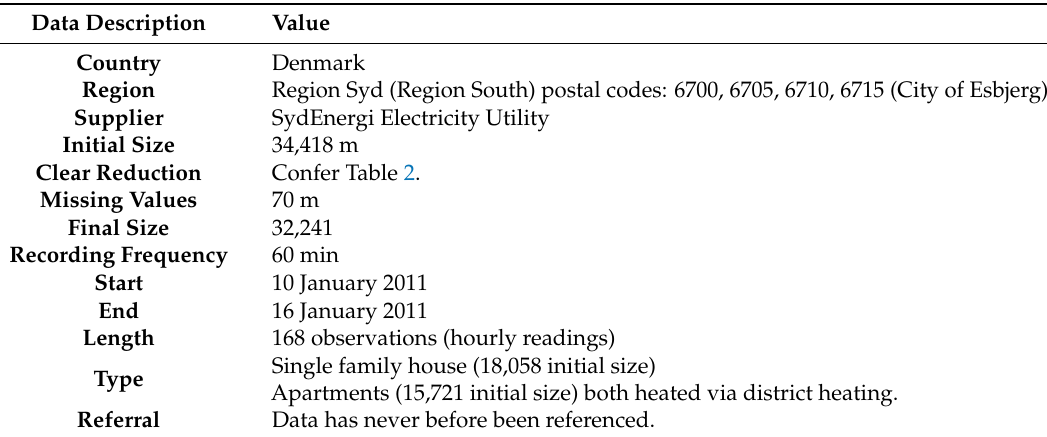
Table 1. Initial data description of SydEnergi data for the city of Esbjerg, comprising 13 distinct quantitative measures of the data applied in the paper. As introduced in